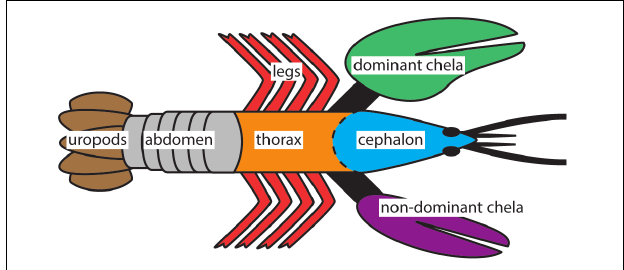
FIGURE 1 | The seven body parts of H. americanus investigated in this study. Three or more samples were collected from each location while also distinguishing between the distal and proximal sites on the chela for a total of 30 exoskeleton samples per animal.